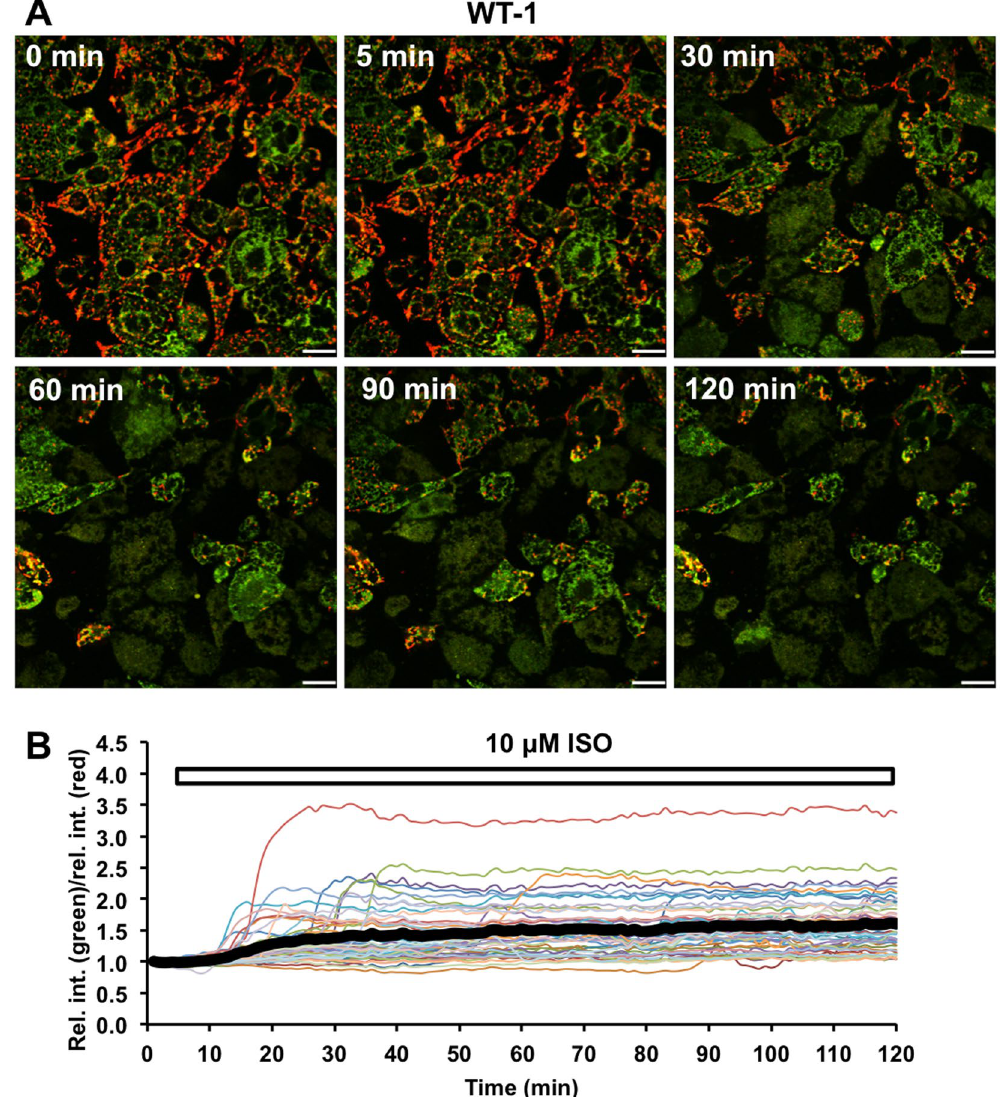
Figure 4. Isoproterenol stimulation induces mitochondrial depolarisation in WT-1 cells. ( A ) In WT-1 cells, red signal (JC-1 aggregates) corresponding to polarised mitochondria disappears and the intensity of green signal (JC-1 monomers) increases after ISO stimulation, indicating depolarisation. For time-lapse video, see Supplementary Video 3. Scale bar: 20 μ m.( B ) The relative intensity ratio of green and red signals is rapidly altered following ISO stimulation in WT-1 cells, indicating mitochondrial depolarisation. These sudden changes occur at different time points in individual cells. The thick black curve represents the average relative intensity ratio of green to red signals in all imaged cells, including responding and non-responding cells; n = 47 cells from 2